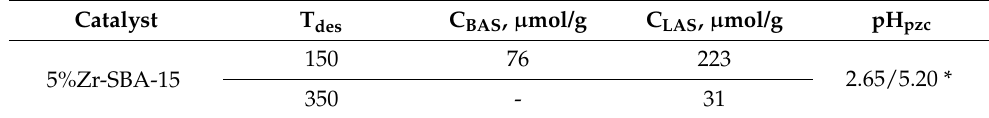
Table 3. The acidic properties of 5%Zr-SBA-15.